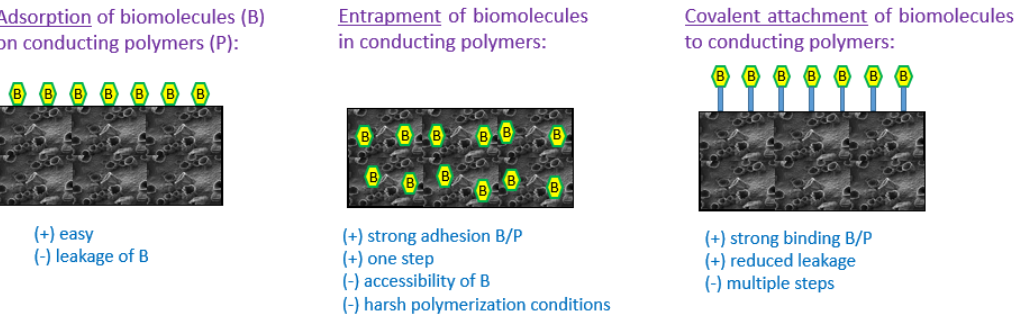
Figure 1. Strategies of immobilization of biomolecules in / on conducting polymers: advantages and drawbacks.